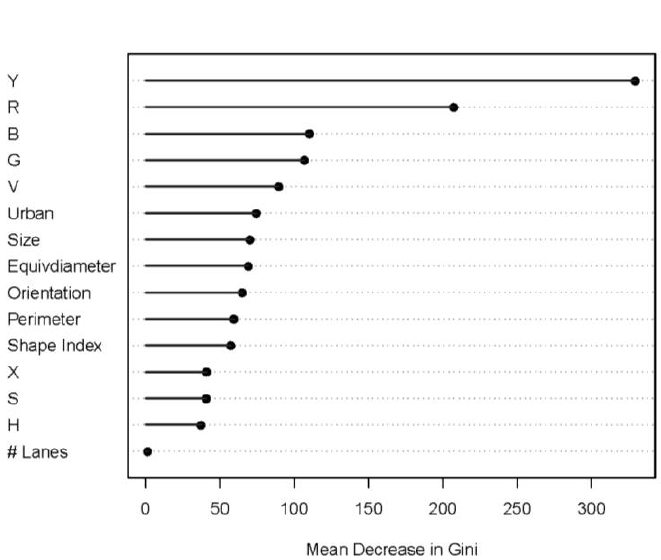
Figure 5. Importance of variables in the random forest model. Table 2. Error rates by varying R (the sidewalk image determination threshold) in the training and test sets.